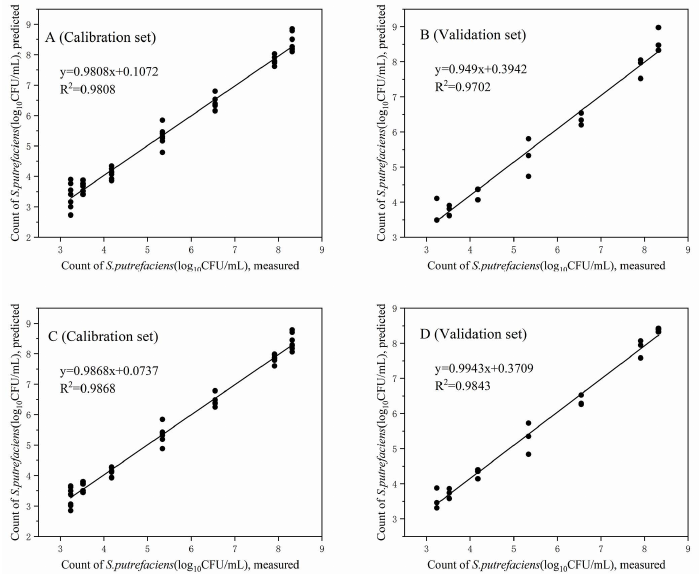
Figure 6. Reference measured data versus predicted data from the PLS models for prediction of the total number of S. putrefaciens (TNS) in tuna stored at 4 ◦ C. ( A , B ): PLS models for calibration and validation set without EC values; ( C , D ): PLS models for calibration and validation set with EC